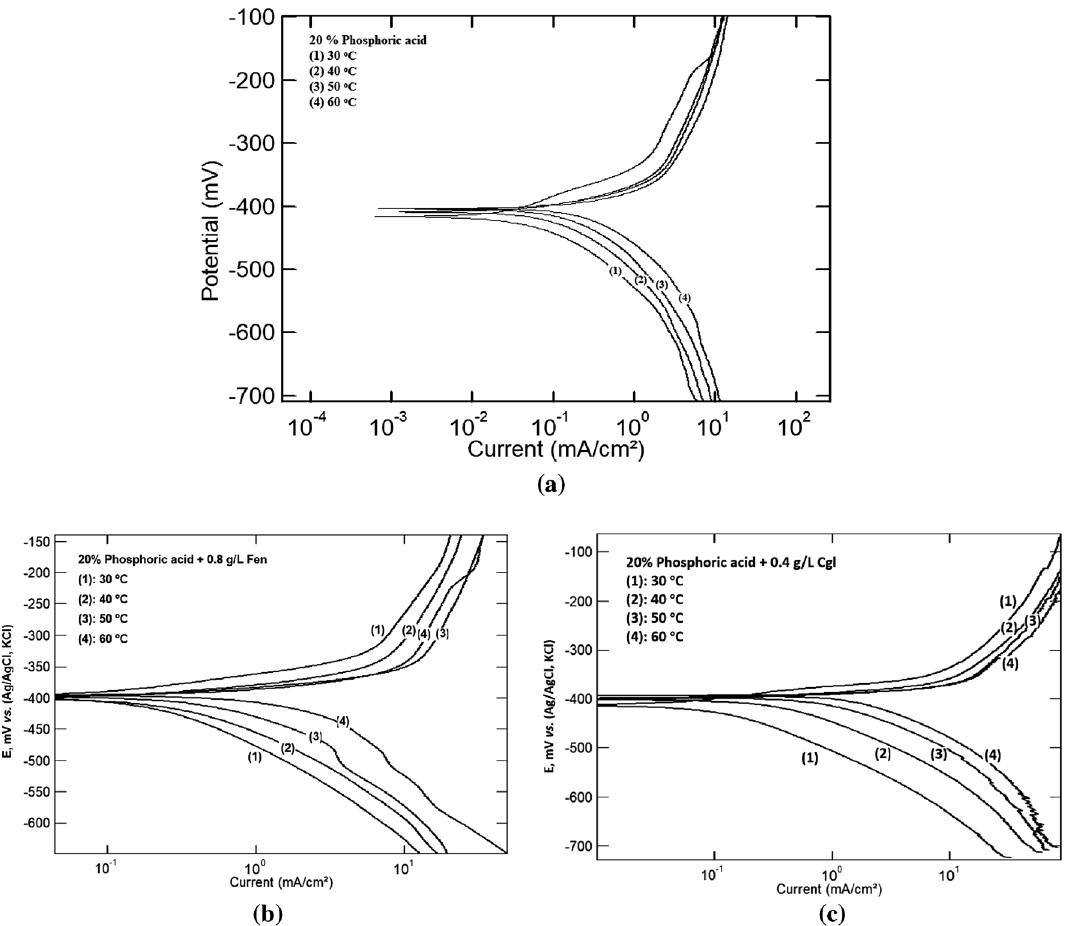
Figure 8. Potentiodynamic polarization curves of steel in 20% phosphoric acid in ( a ) the absence and presence of ( b ) 0.8 g/L Fen and ( c ) 0.4 g/L CgL extract at different temperatures.